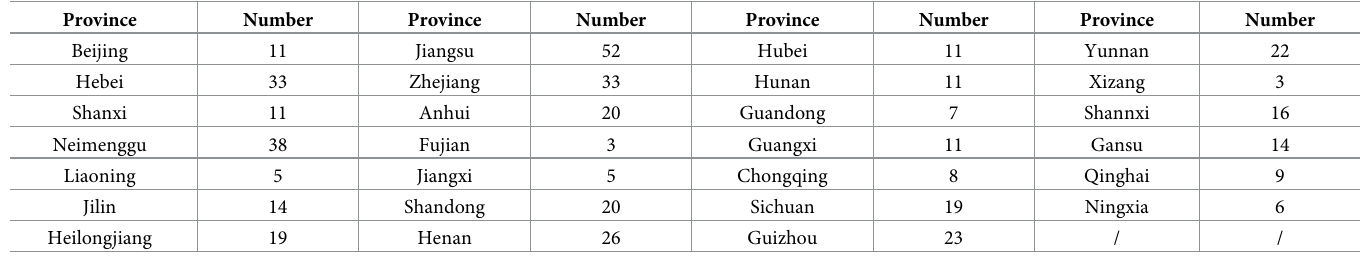
Table 1. Number of provincial boundary monitoring